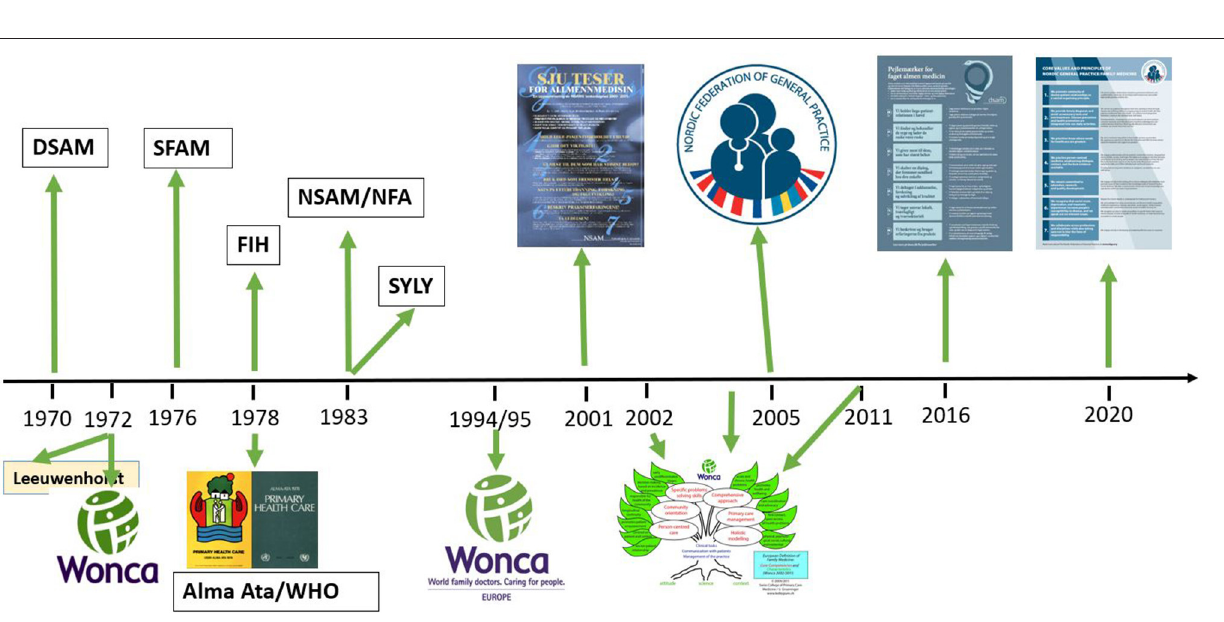
FIGURE 1 | Milestones on our way toward the Nordic core values and principles of general practice (DSAM, Danish College of General Practice; Wonca, World Organization of Family Doctors; SFAM, Swedish College of General Practice; FIH, The Icelandic College of Family Physicians; NSAM/NFA, The Norwegian College of General Practice; SYLY, The Finnish Association of General